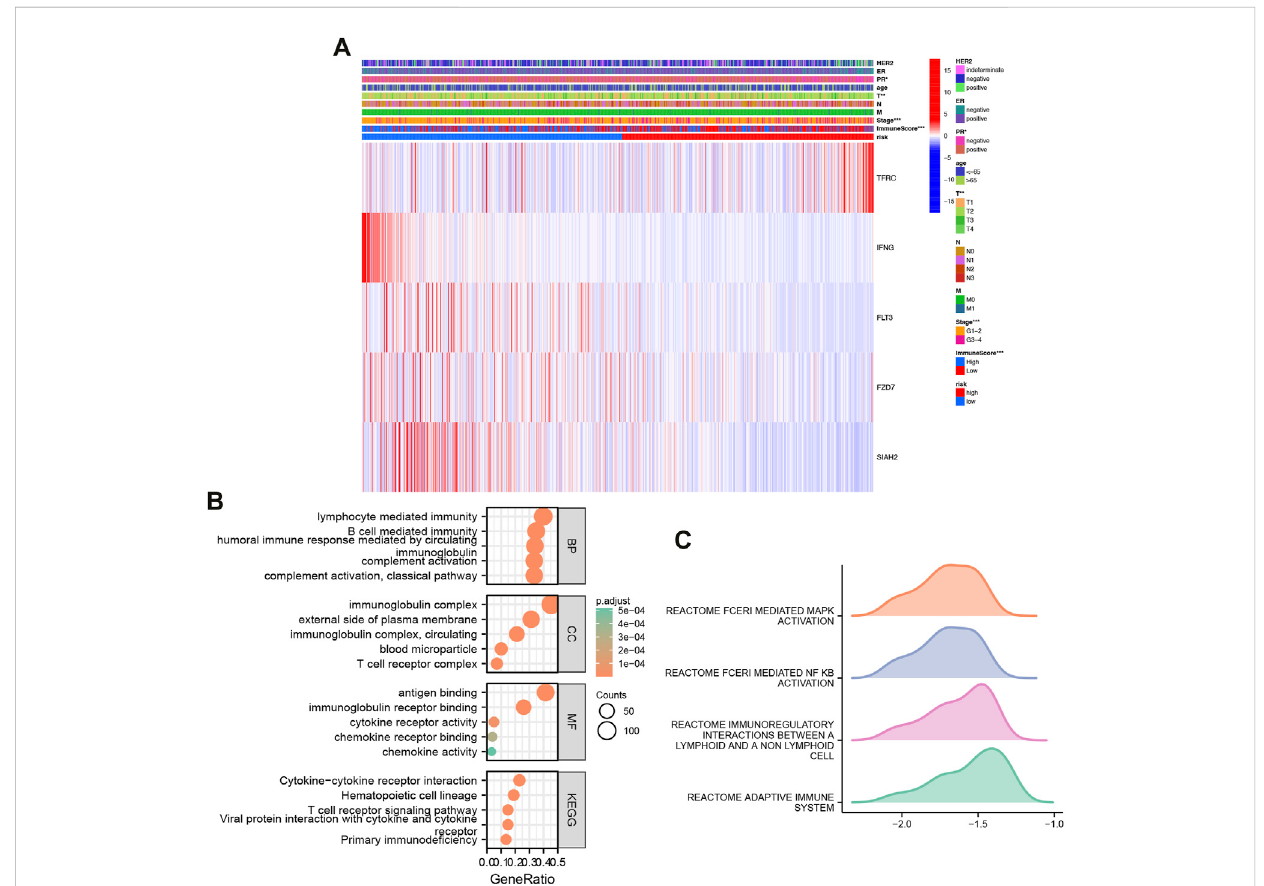
FIGURE 4 Heatmap and GO/KEGG pathway enrichment analysis. (A) Clinically relevant heatmap. A heatmap based on data on the clinicopathological characteristics of the patients was created based on the risk characteristics associated with prognosis. * p < 0.05, ** p < 0.01, *** p < 0.001. (B) Gene Ontology (GO) and Kyoto Encyclopedia of Genes and Genomes (KEGG) analysis of high and low risk differential genes. (C) GSEA analysis of high and low risk differential